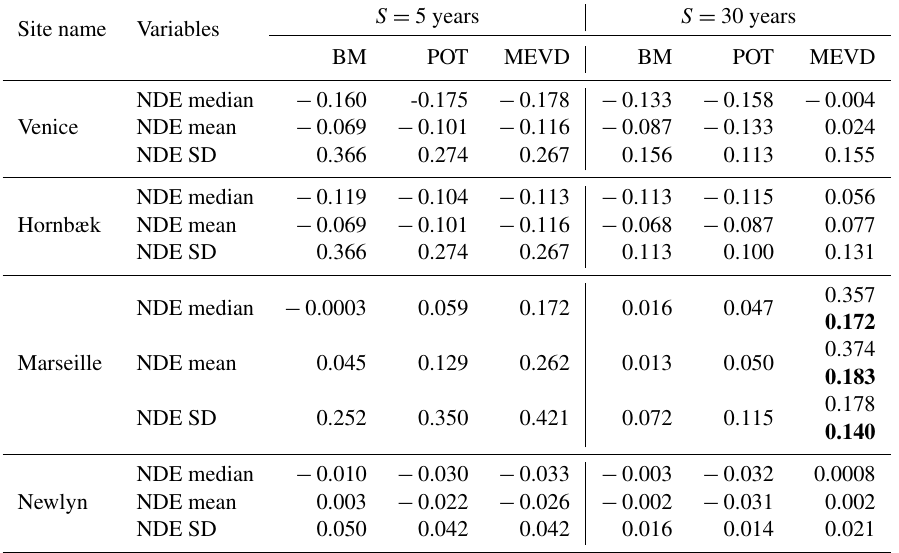
Table 3. Results of the evaluation metric obtained for all the gauge stations and for calibration sample sizes ( S ) equal to 5 and 30 years. In the case of the Marseille site, text in bold refers to MEVD parameter estimation based on data from the whole calibration sample